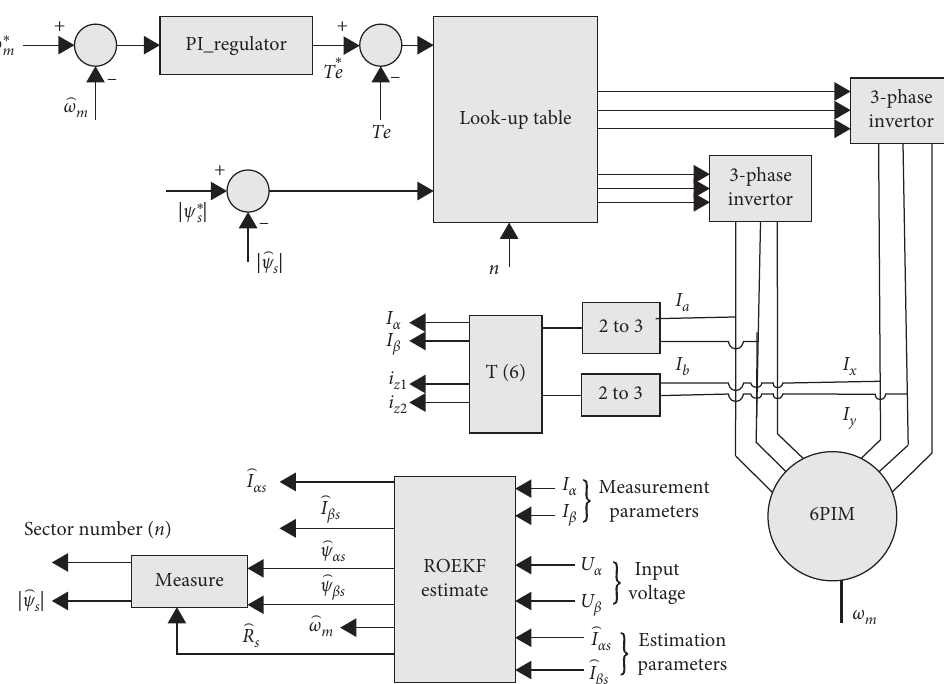
Figure 1: Diagram of reduced order EKF modeling of DTC of the six-phase induction